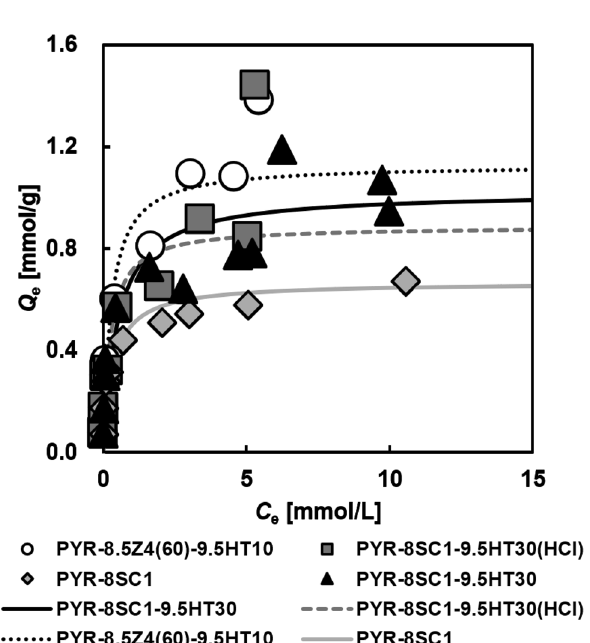
Fig. 4 Adsorption isotherms of nitrate at equilibrium solution pH